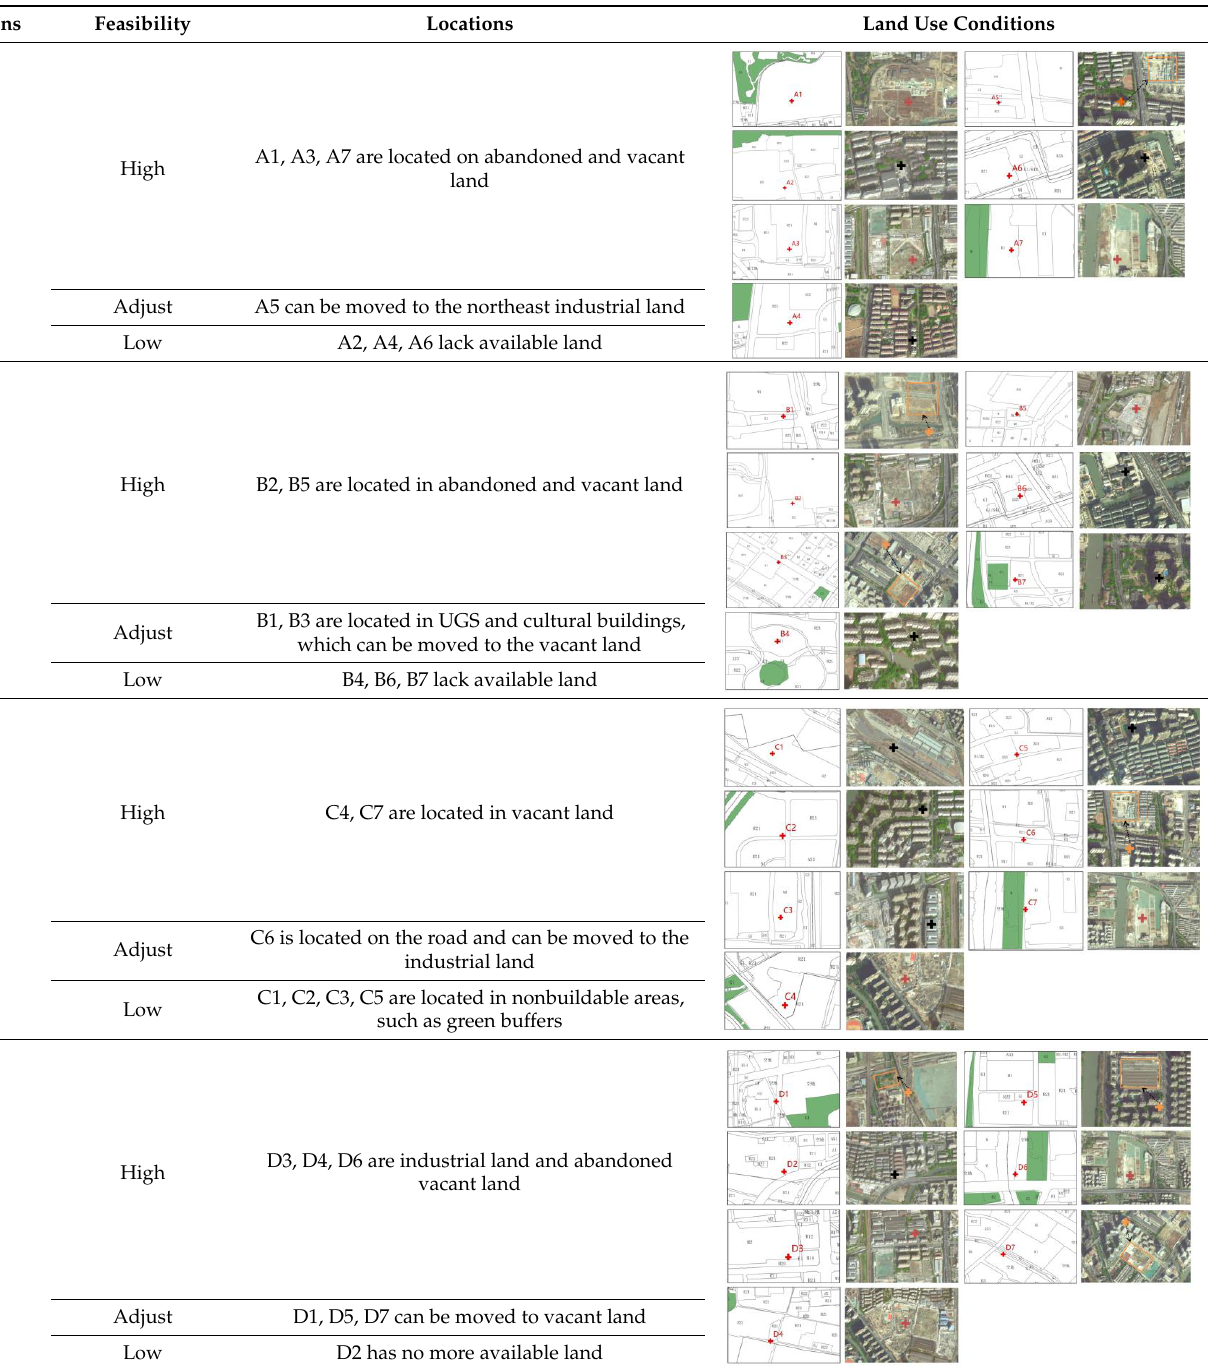
Table 2. Land use conditions and feasibility analysis of locations.